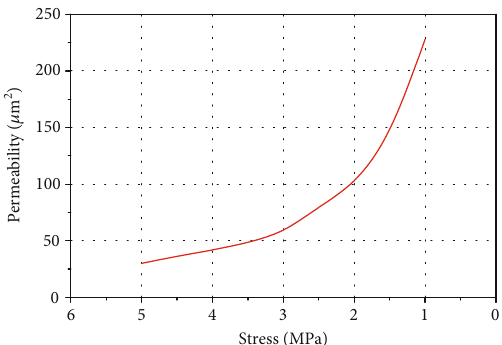
Figure 9: Change curve of permeability with con fi ning pressure for the coal specimen 1.